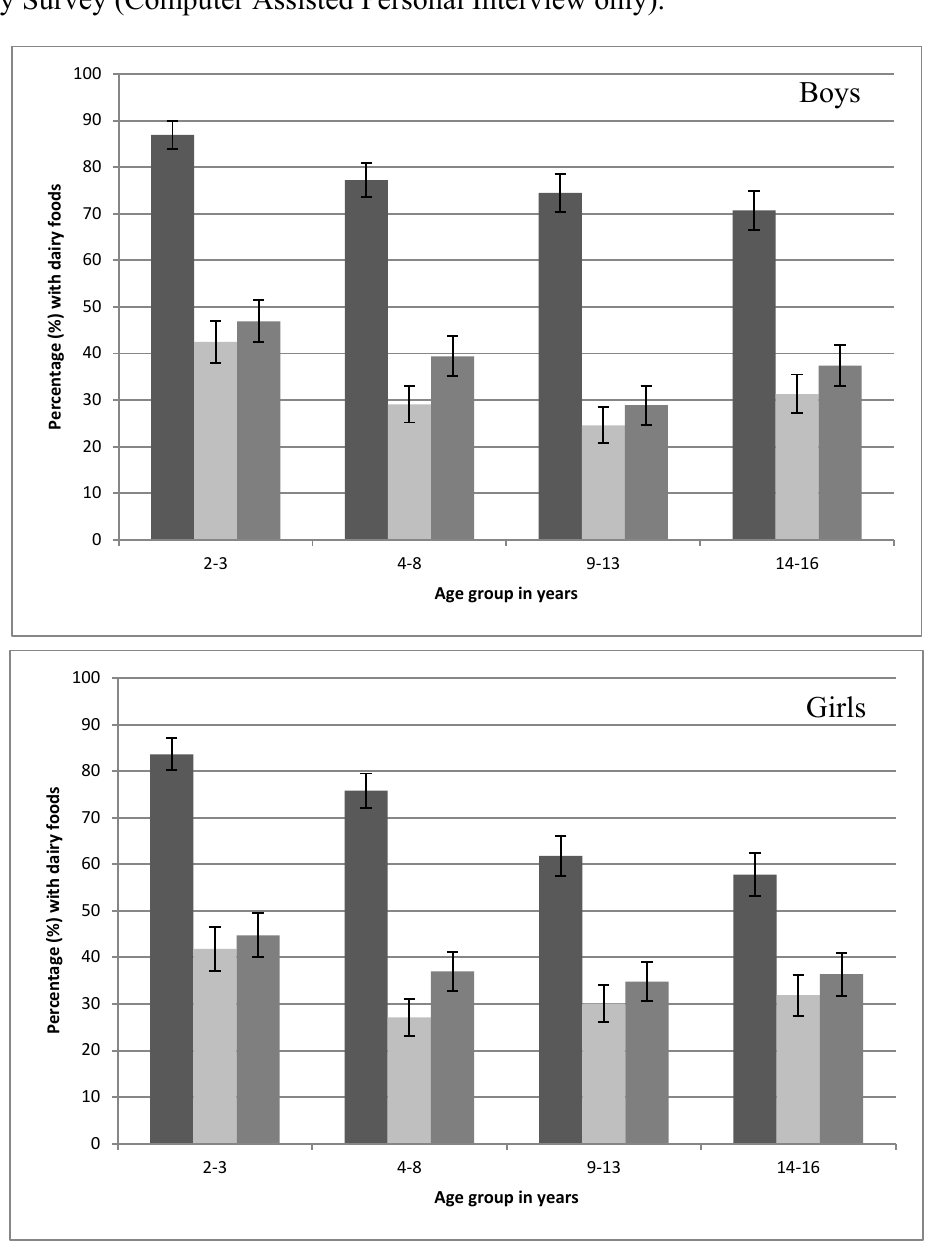
Figure 1. Percentage (±95% CI) of the first three eating occasions ( first eating occasion, second eating